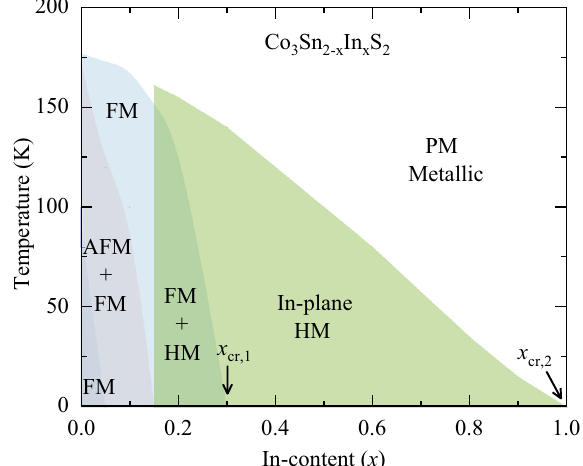
Fig. 1 (Color online) Schematic temperature-doping magnetic phase diagram of CoSn 2 − x In x S 2 . FM, AFM, and HM denote the out- of-plane ferromagnetic, in-plane antiferromagnetic and in-plane helimagnetic orders, respectively (see the text for the